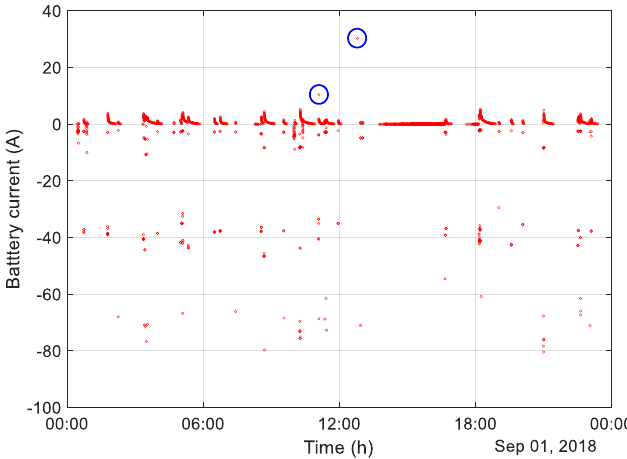
Figure 6. KOMPSAT-5 housekeeping data noise.